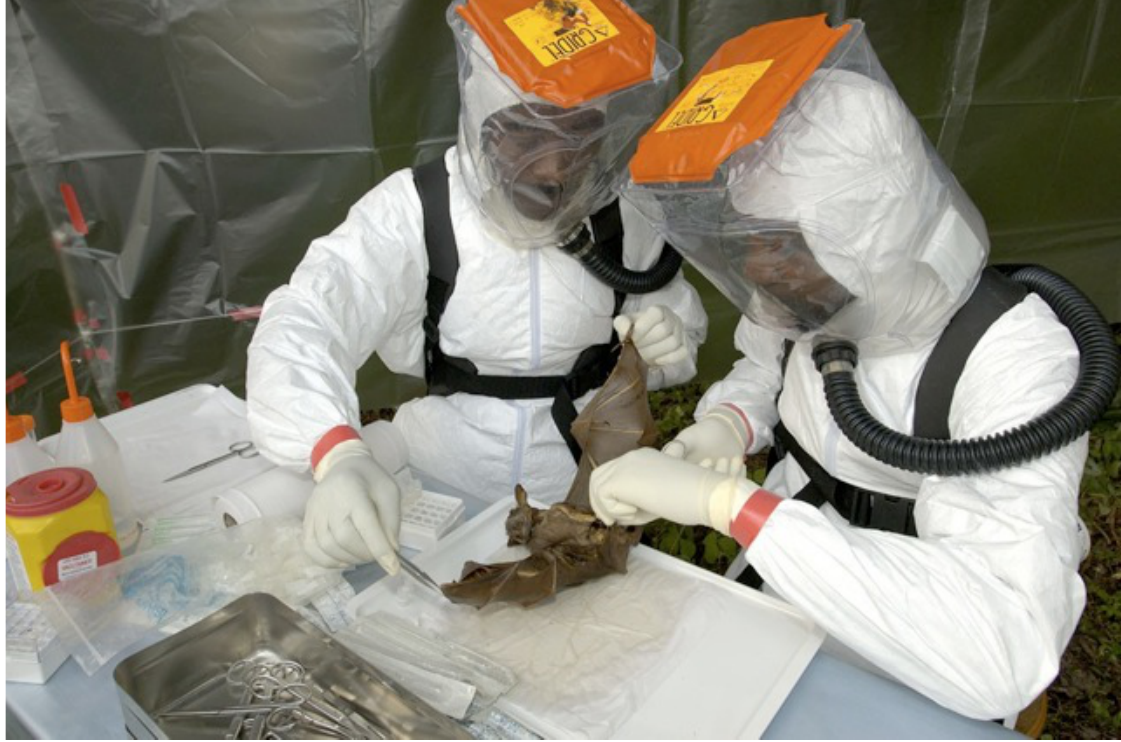
Figure 4. Field Biosafety and Trapping Potential Ebola Virus Reservoir Bats in